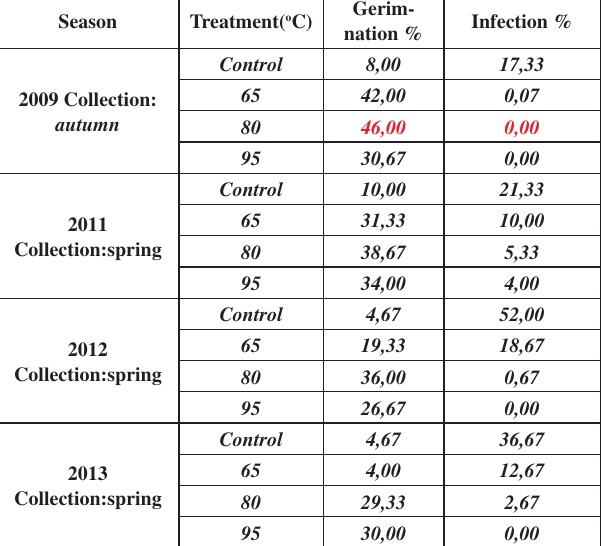
Table 1 : Influece of hot water treatment on germination (%) and infection (%) of Sida hermaphrodita L. RUSBY seeds Gerim- Season Treatment( o C) nation %